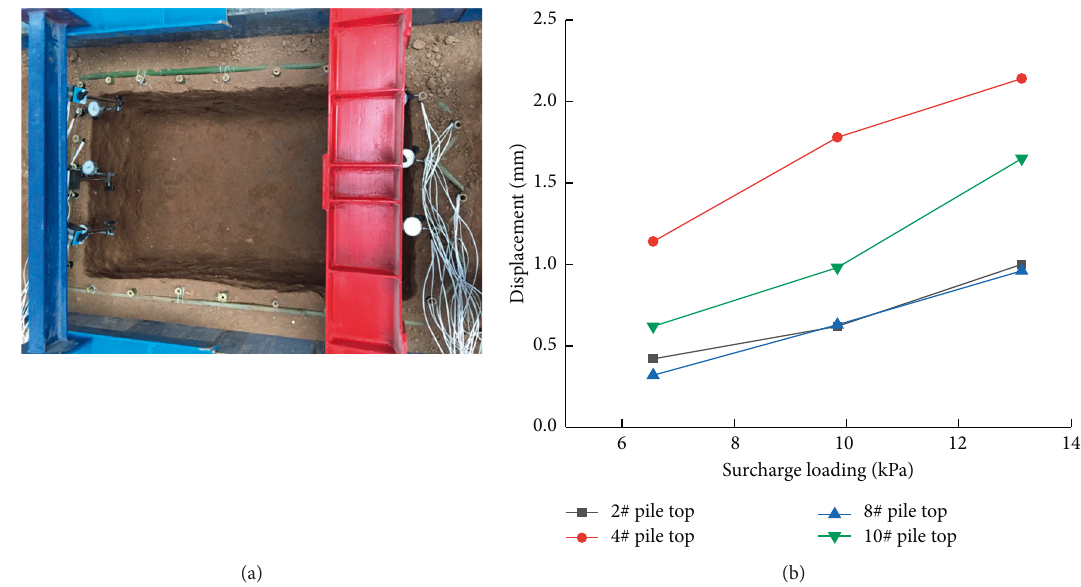
Figure 8: Column top displacement measurement. (a) Dial indicator layout. (b) Pile top displacement